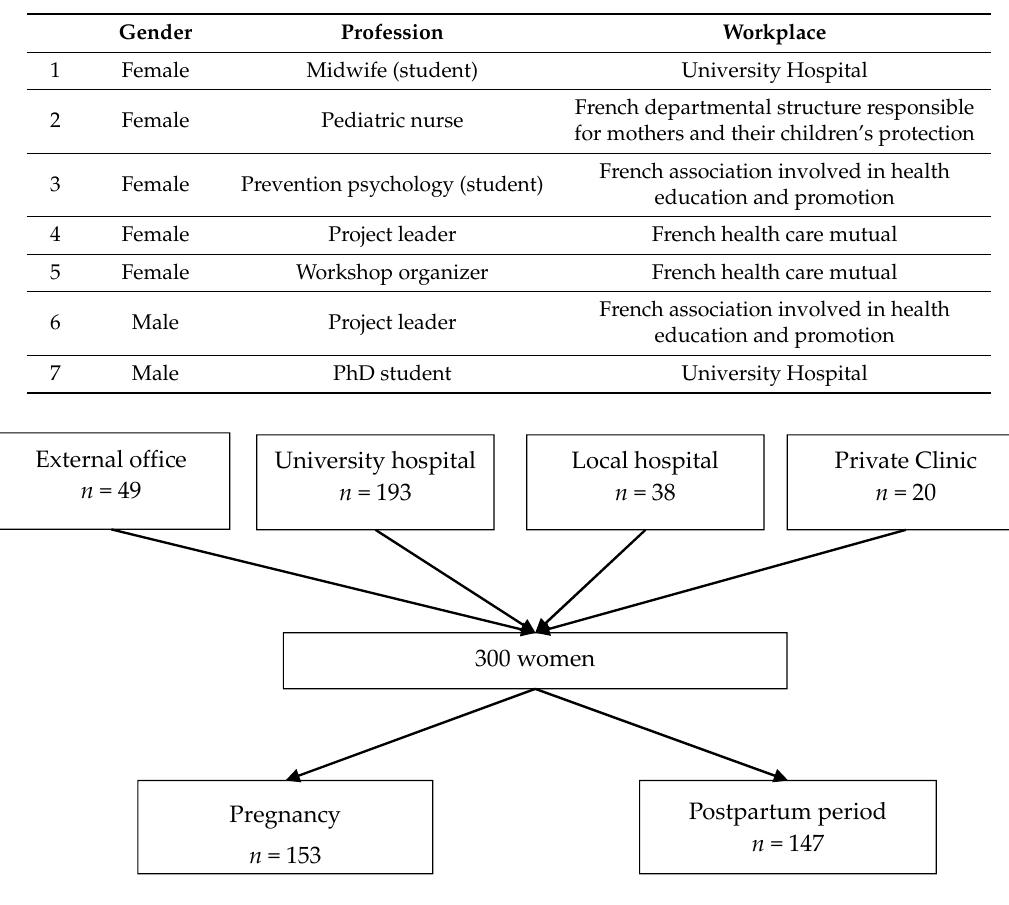
Figure A1. Flowchart of the quantitative study population.